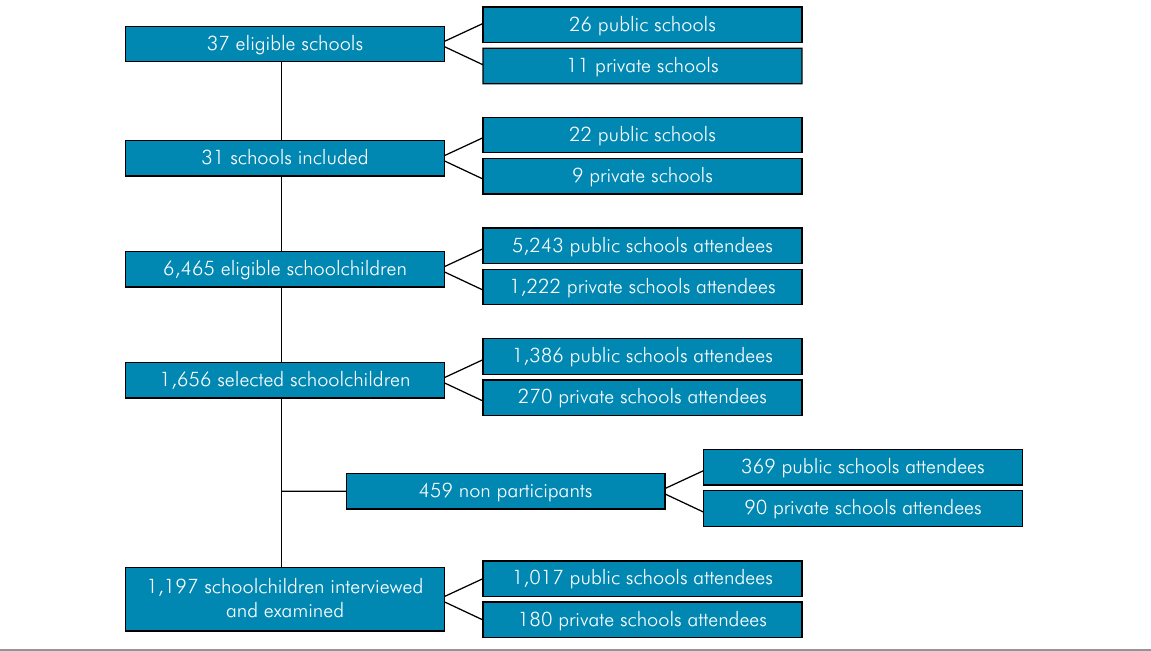
Figure 1. Flowchart of the